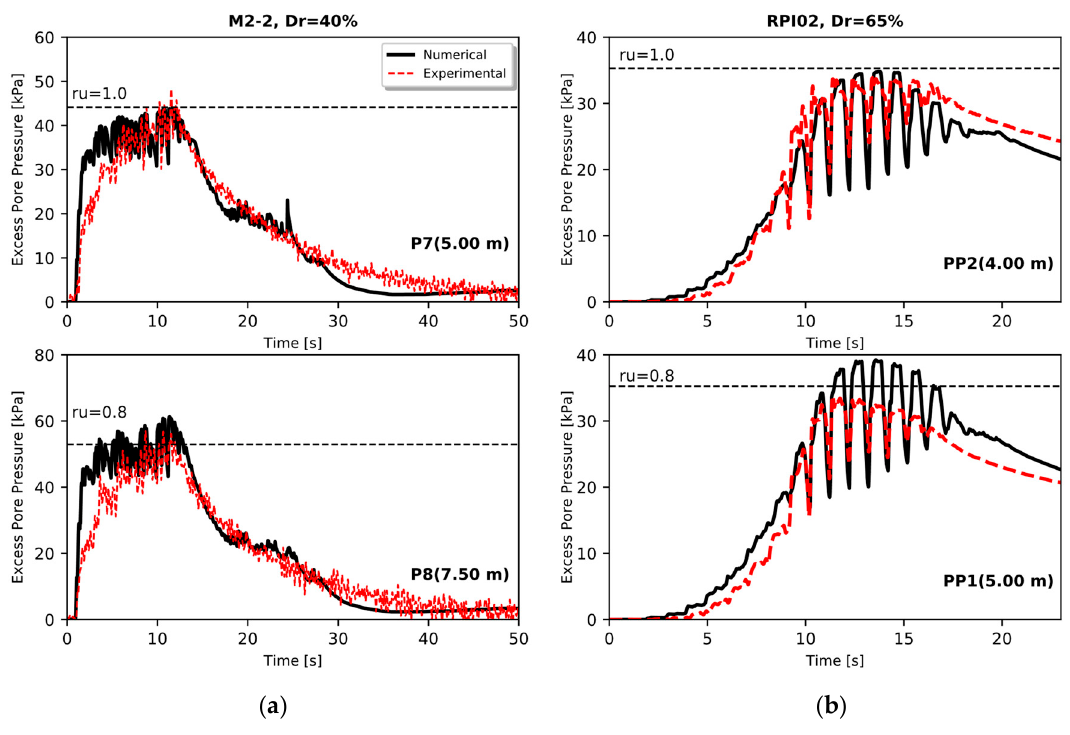
Figure 11. Numerical versus experimental excess pore pressure in ( a ) M2-2 and ( b ) RPI-02 at two different depths.